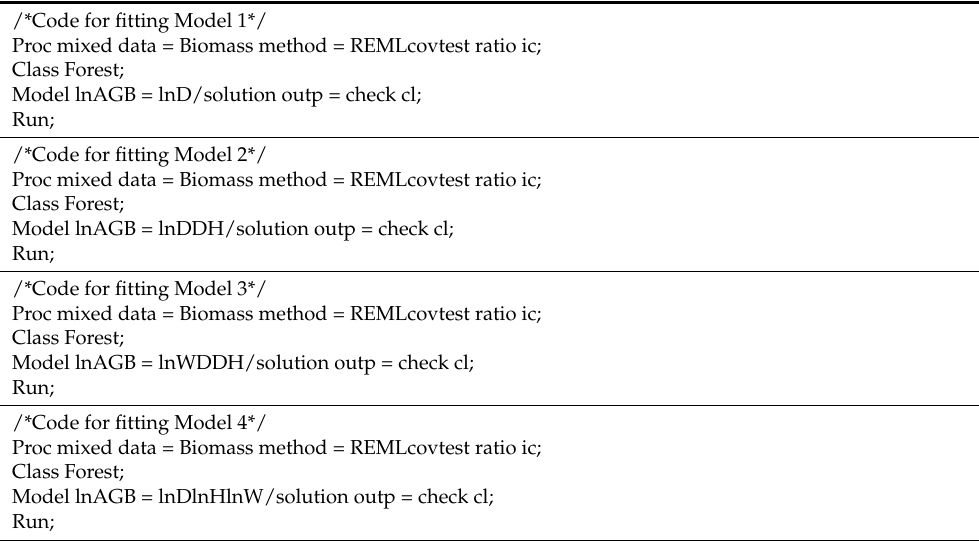
Table A1. PROC MIXED codes for estimating parameters of the conventional models.